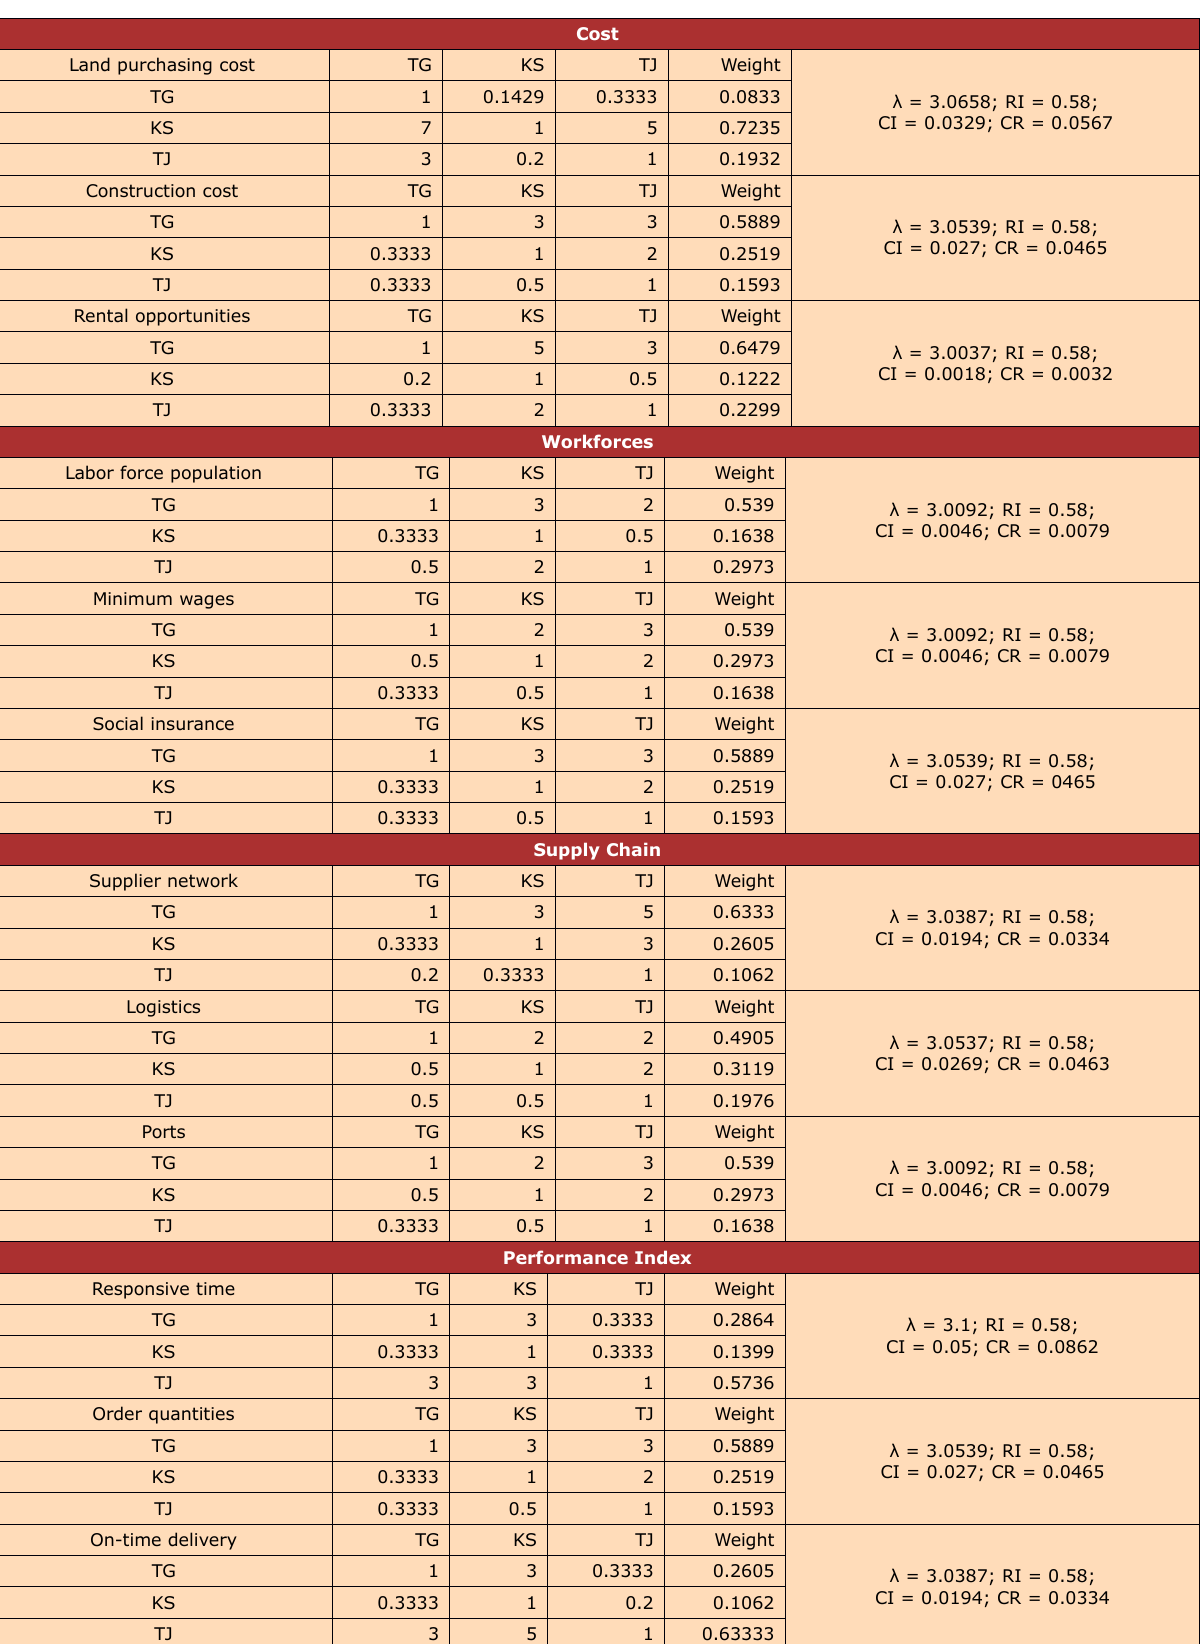
Table 11. Pair-wise comparison matrix among alternatives for subcriteria under cost Table 11 shows the pair-wise comparison results among alternatives for twelve subcriteria. In Table 11, results of land purchasing cost, construction cost, and rental opportunities are